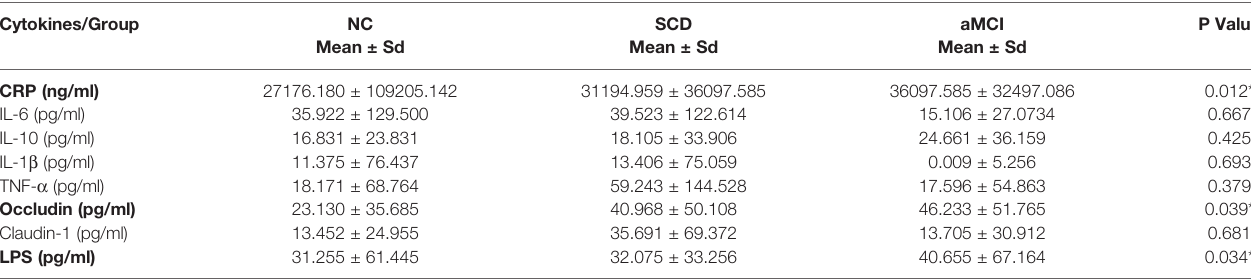
TABLE 5 | Levels of serum cytokines among three